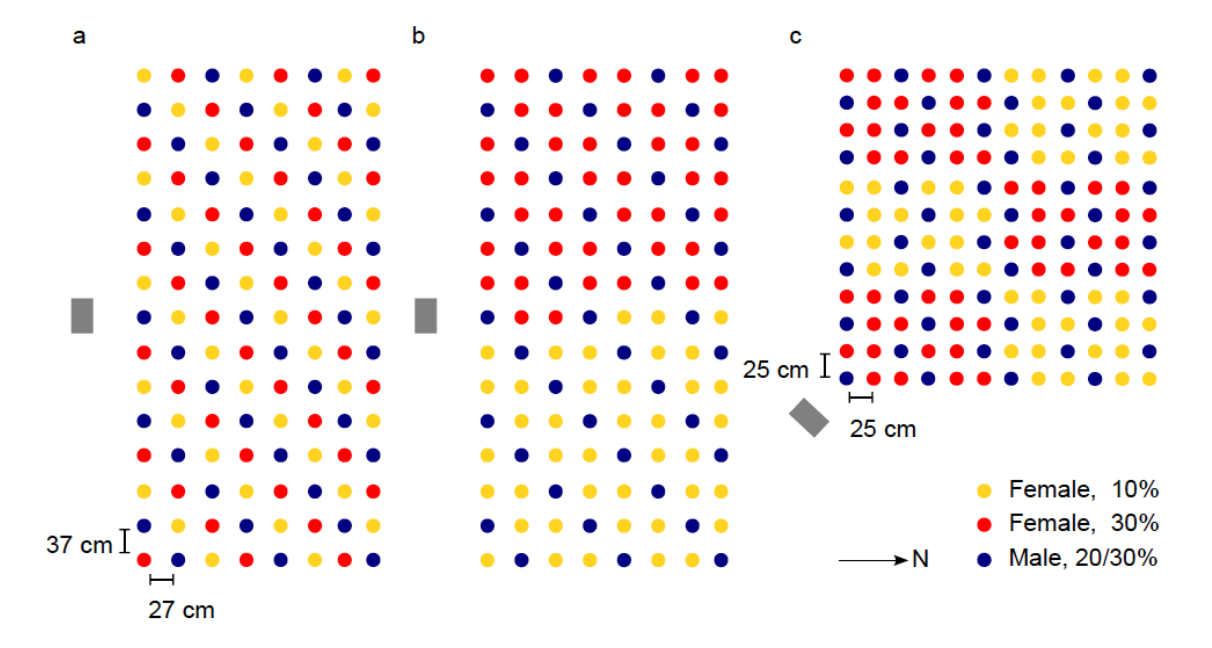
F IGURE 3. Designs of the artificial flower arrays for Experiments 1-3. All flowers were painted blue; colours in this figure simply denote different flower types. In Experiment 1 (a), rich (30%-sucrose nectar) and poor (10%-sucrose nectar) female flowers were intermingled throughout the array. In Experiment 2 (b), the two female flower types were spatially clustered into two large patches comprising the western and eastern halves of the array. Experiment 3 (c) imposed an intermediate degree of clustering. Experiments 1 and 2 were conducted in a greenhouse and had equivalent flower spacing, while Experiment 3 was conducted in an indoor flight cage with closer flower spacing. In Experiment 1, males had 20%-sucrose nectar, while in Experiments 2 and 3 the males had 30%-sucrose nectar. Grey rectangles show the position of the Bombus impatiens colony box for each